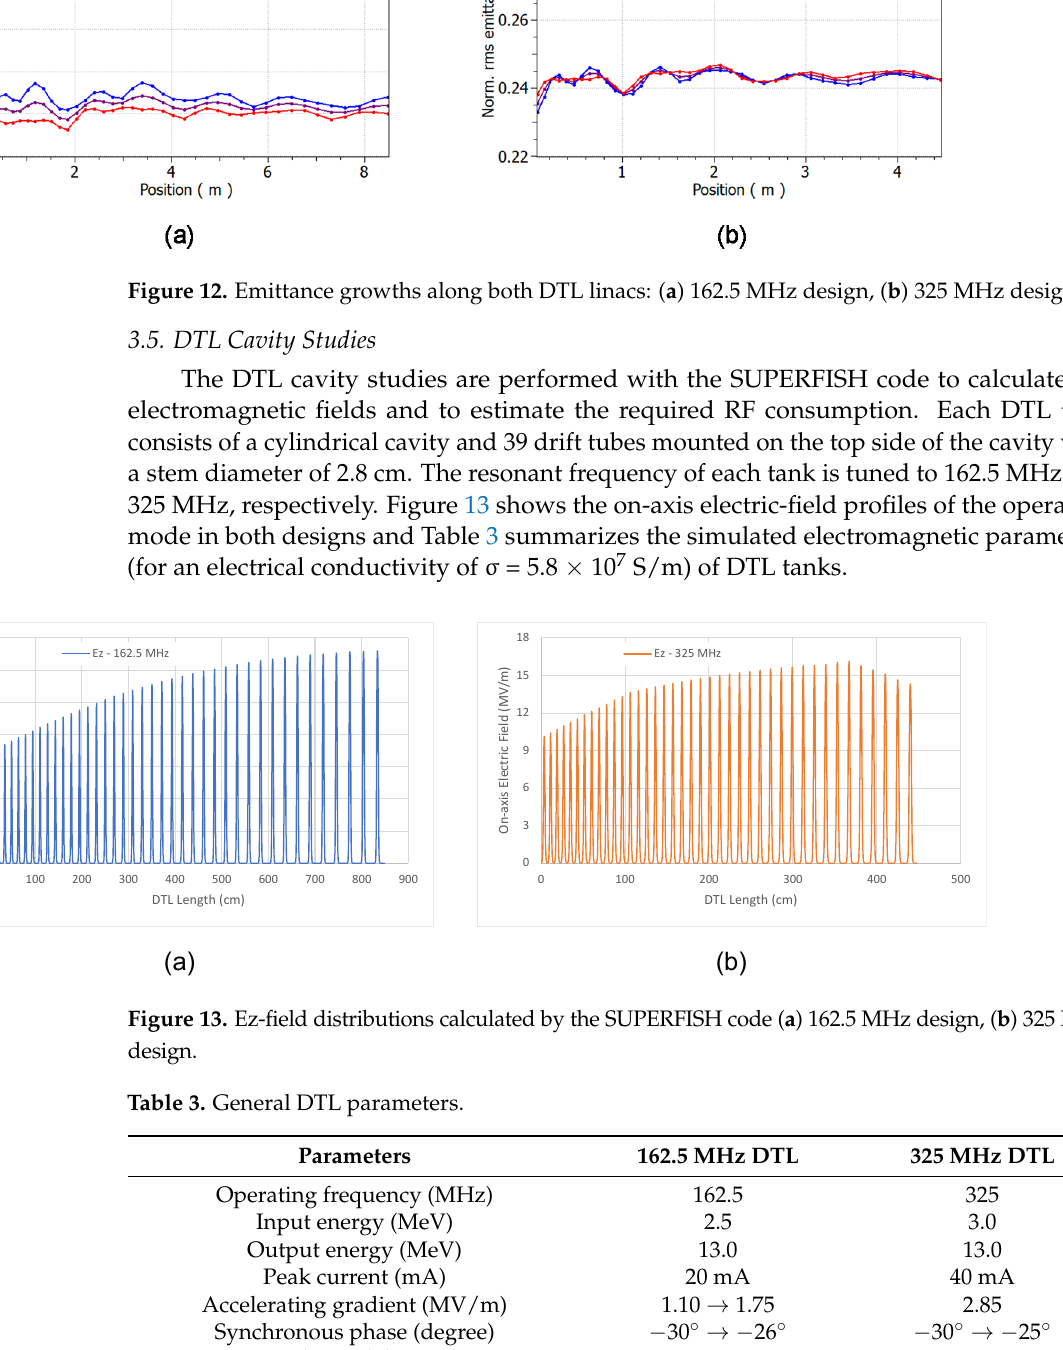
162.5 MHz design, ( b ) 325 MHz design.